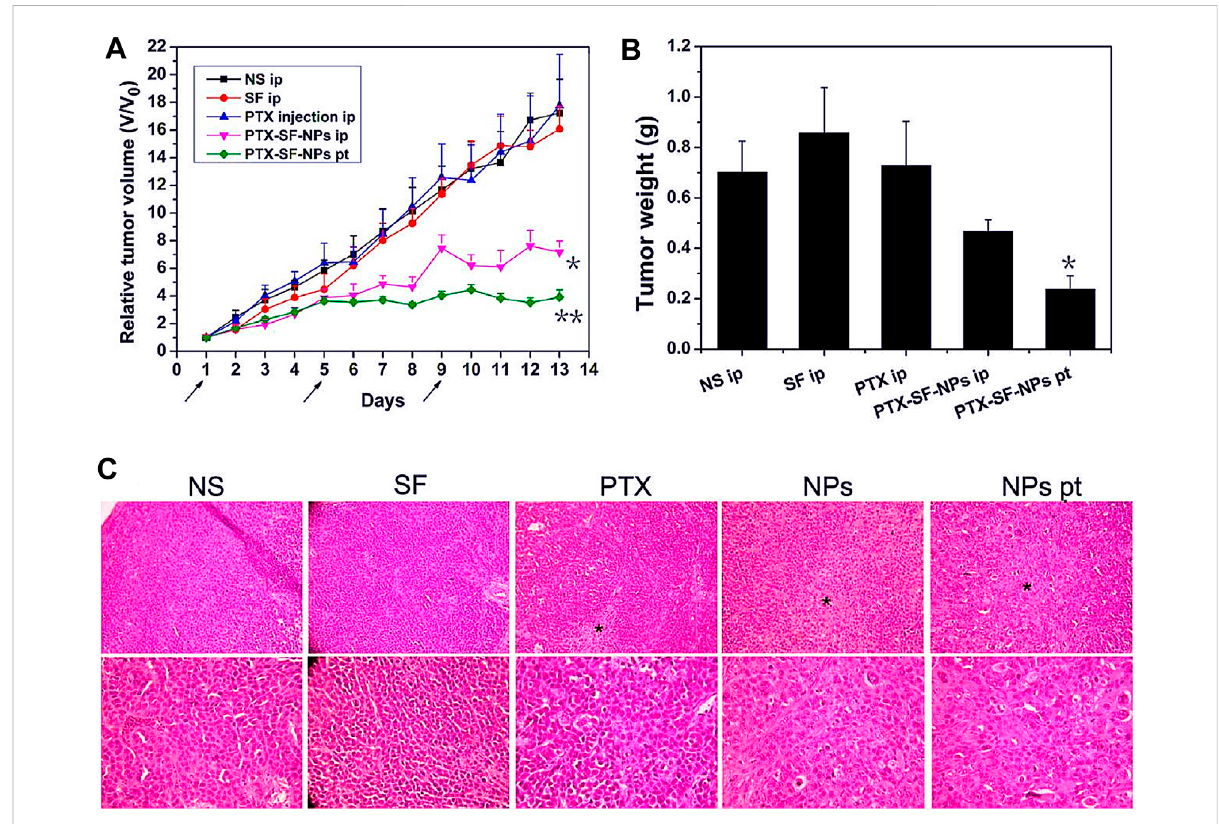
FIGURE 4 Antitumor ef fi cacies of PTX-SF-NPs for systemic and focal treatment in human gastric cancer BGC-823 nude mice xenograft model. (A) Relative tumor volumes during treatment. (B) Absolute tumor weights on Day 14. (C) H&E staining of tumors Notes: Wu, P., Liu, Q., Li, R., Wang, J., Zhen, X., Yue, G., Wang, H., Cui, F., Wu, F., Yang, M., Qian, X., Yu, L., Jiang, X., Liu, B., 2013. Facile preparation of paclitaxel loaded silk fi broin nanoparticles for enhanced antitumor ef fi cacy by locoregional drug delivery. ACS Applied Materials and Interfaces 5, 12638 – 12645